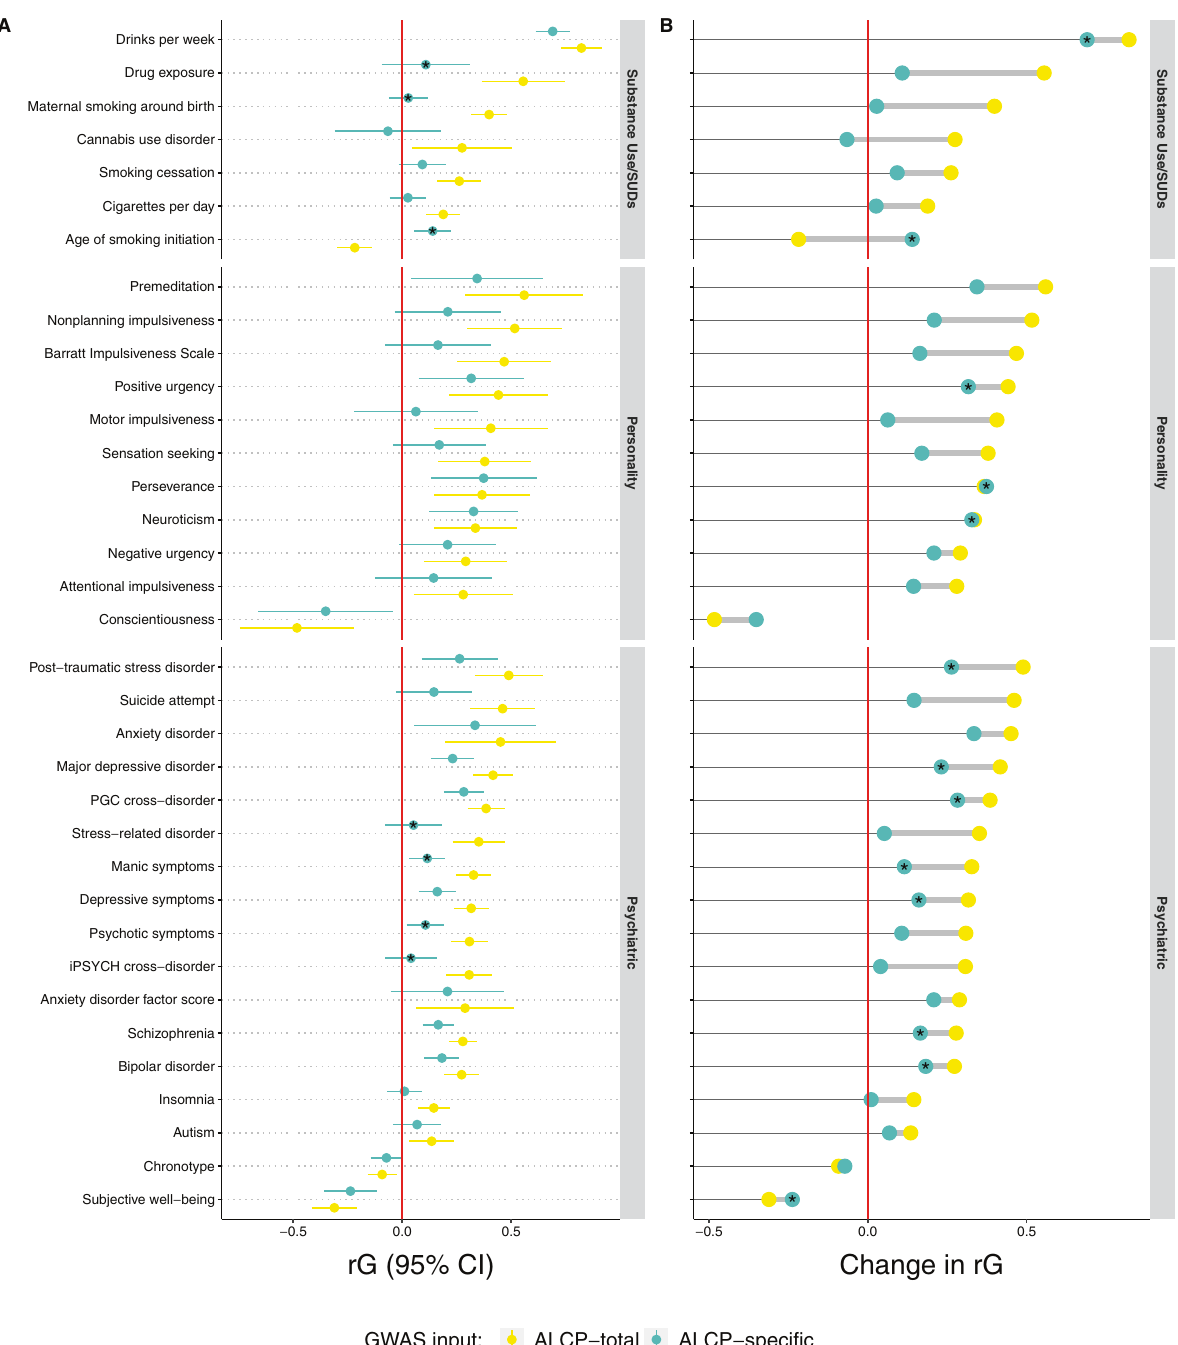
Fig. 2 Values and differences in genetic correlations for ALCP-total and ALCP-speci fi c. Panel ( A ) presents the genetic correlations ( r g ) and 95% CI between problematic alcohol use (ALCP-total, yellow dots), problematic alcohol use-speci fi c (ALCP-speci fi c, teal dots), and selected traits signi fi cantly correlated with ALCP-total (after correcting for an FDR of 5%, Supplementary Table 2 reports all preregistered genetic correlations). Asterisks (*) in Panel ( A ) represent genetic correlations for ALCP-speci fi c that differ signi fi cantly from those with ALCP-total. Panel ( B ) presents changes in point estimates for genetic correlations from ALCP-total to ALCP-speci fi c. In Panel ( B ), asterisks represent genetic correlations for ALCP-speci fi c that are still signi fi cant (after correcting for an FDR of variance in COGA. Supplementary Table 3 presents a full SUD criterion counts . Neither the ALCP-total PGS nor the ALCP- comparison of the EXT, ALCP-speci fi c, and ALCP-total PGS for speci fi c PGS were associated with ever using alcohol in Add AUD criterion counts. The ALCP-total PGS was associated with Health or COGA. For AUD criteria, the ALCP-total PGS explained cannabis use and other substance use in Add Health (OR ALCP- 0.52% of the variance ( Δ R 2 ) in Add Health and 1.72% of the ALCP - total = 1.15 – 1.20, Δ R 2 = 0.56 – 0.90%) and all forms of use in COGA variance in COGA, compared to the ALCP-speci fi c PGS, which total explained 0.28% of the variance in Add Health and 0.85% of the (OR ALCP-total = 1.20 – 1.27, Δ R 2 = 0.65 – 1.26%). Additionally, the